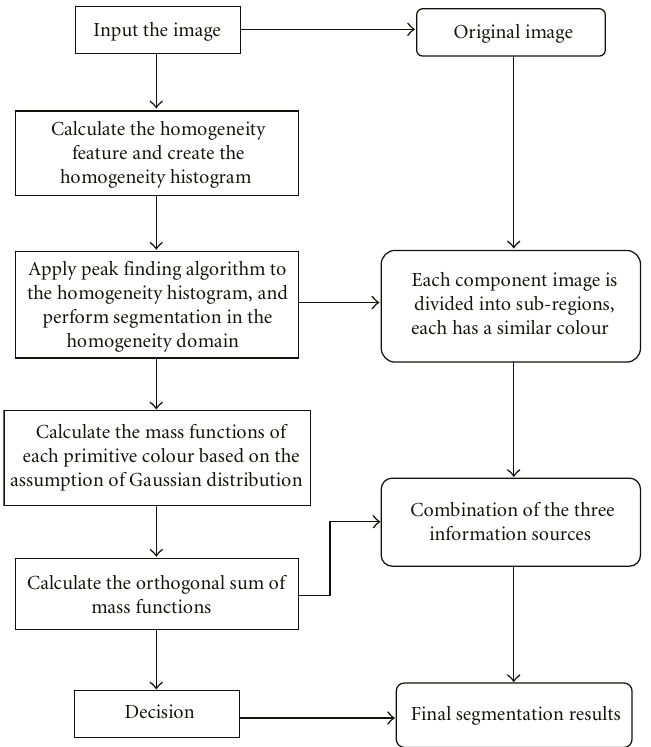
Figure 1: Flowchart of the proposed